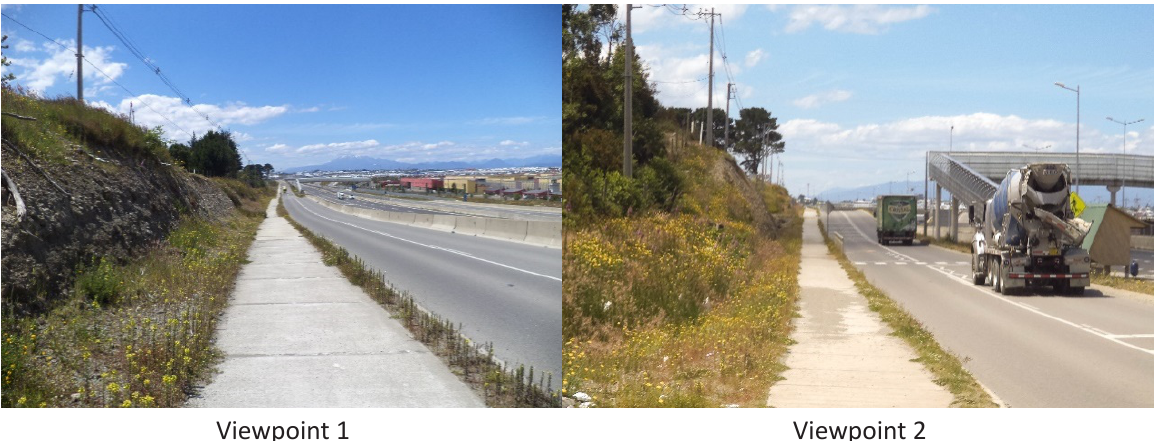
1-2.Viewpoint 1 Viewpoint Figure 6: of landscape and man-made obstructing objects from viewpoint